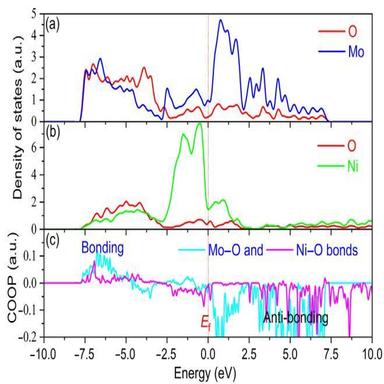
(Color online) Partial density of states for Mo–O (a), Ni–O (b) interfaces, and their COOP (c).